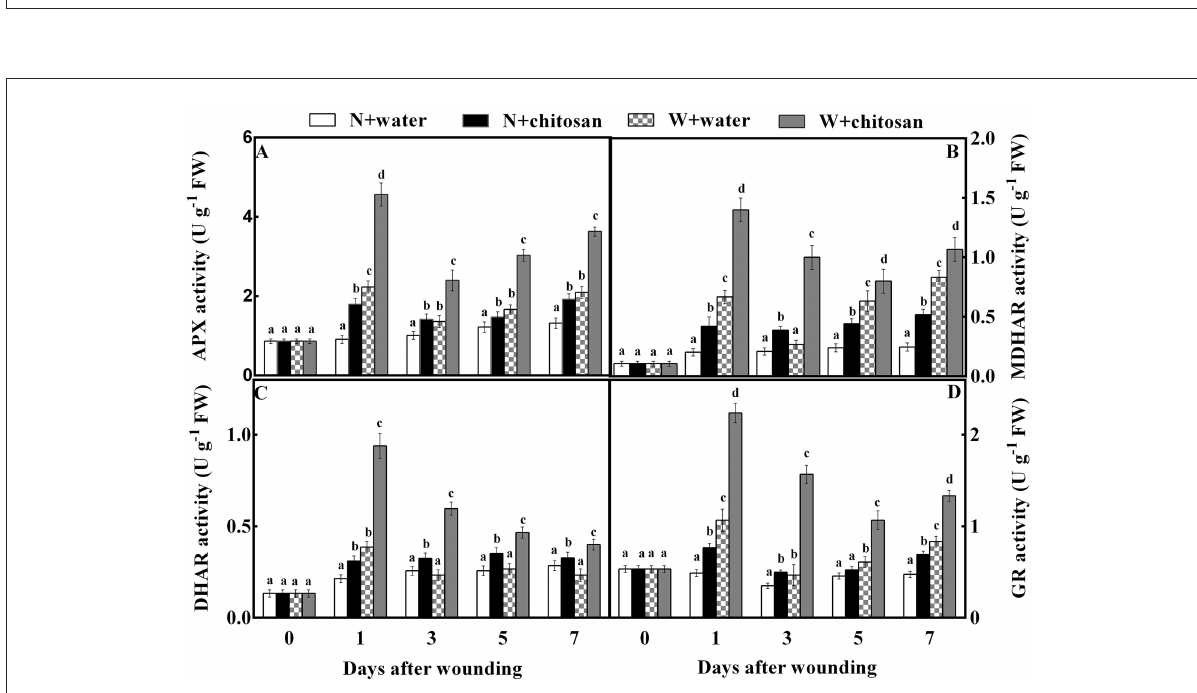
FIGURE4 Effect of chitosan treatment on the activities of APX (A) , MDHAR (B) , DHAR (C) , and GR (D) at apple wounds. Non-wounded fruit treated with sterile water (N + water), non-wounded fruit treated with chitosan (N + chitosan), wounded fruit treated with sterile water (W + water), and wounded fruit treated with chitosan (W + chitosan). Vertical bars indicate standard error of means. For each day after wounding, alphabets indicate significant differences ( P <